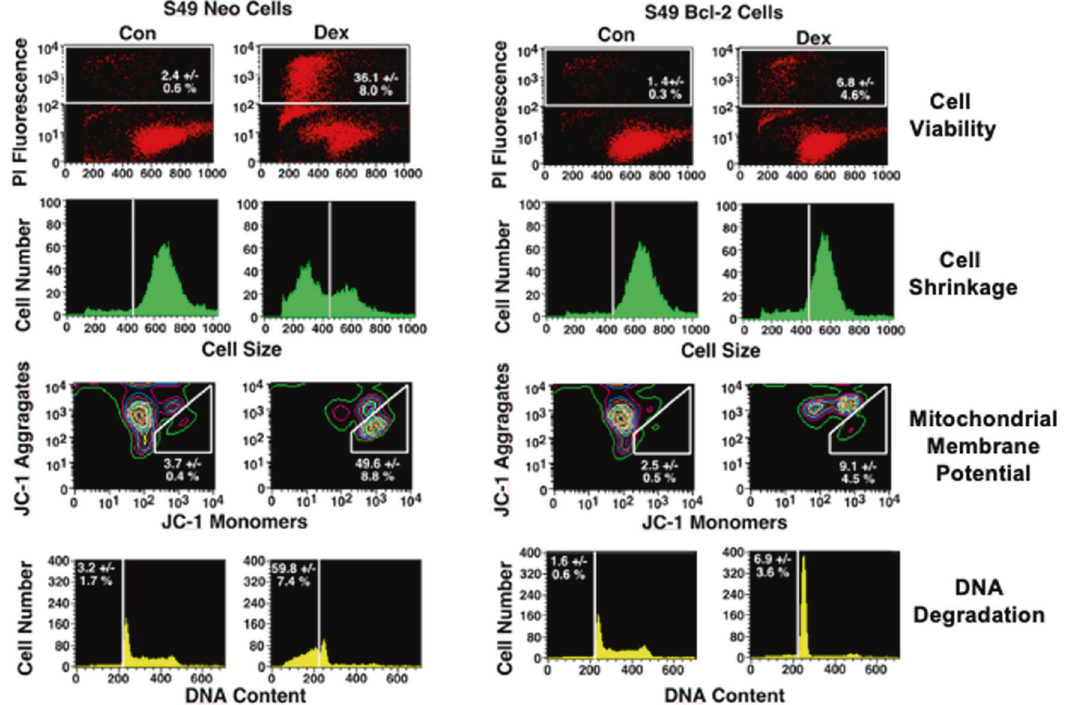
Fig. 1 Bcl-2 prevents classical characteristics associated with dex-induced apoptosis in S49 T cells. S49 (Neo) cells treated with 2.5 × 10 − 7 M dex for 48 h resulted in the loss of membrane integrity as determined by the increase in the number of cells which were stained with the vital dye, propidium iodide (PI), an increase in the number of cells which had a decrease in their ability to scatter light in the forward direction, indicating a population of cells with decreased cell size, depolarization of the mitochondrial membrane potential (MMP), evident by the increase in JC-1 monomers and decrease in JC-1 aggregates, and the presence of a sub-diploid peak of DNA, indicative of degraded DNA. In contrast, S49 (Bcl-2) cells treated with dex under identical conditions did not result in any signi fi cant changes in membrane integrity or cell size. Interesting, mitochondrial membrane hyperpolarization was observed along with a block at the G1/S phase of the cell cycle. Data represent the mean ( + / − SEM) of 3-5 independent